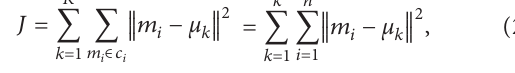
Figure 2: Mean clustering simulation